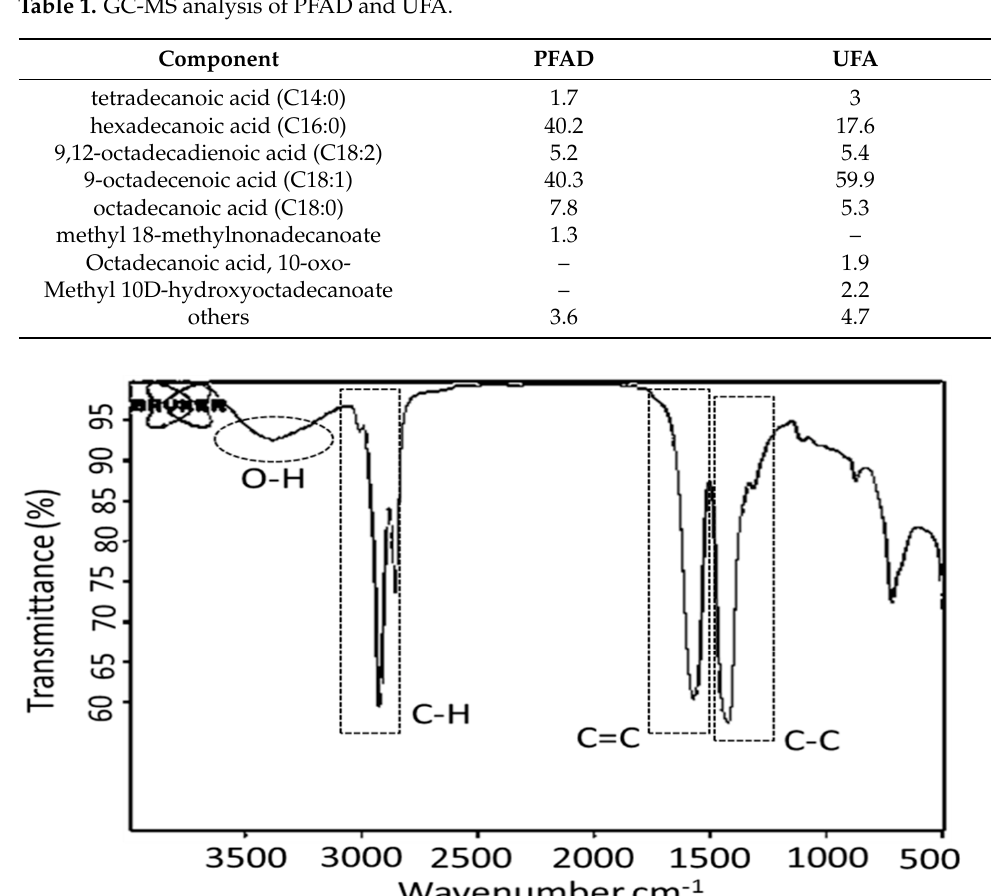
Figure 2. FT-IR of mixed-metal basic soap of unsaturated fatty acid.